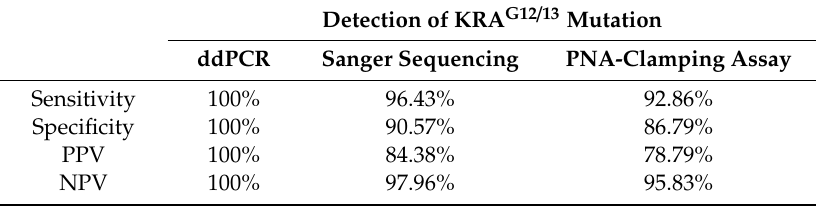
Diagnostic value of KRA G12 / 13 mutation detection by ddPCR, Sanger sequencing, and PNA-clamping